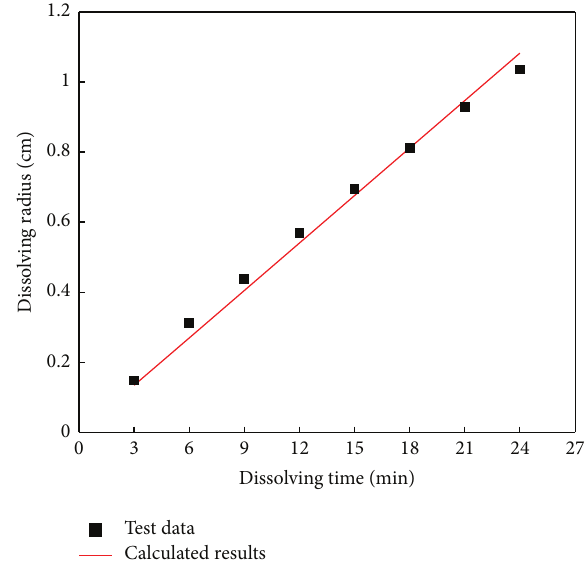
Figure10:Comparisonofthedissolvedradiusbetweentestdataand calculated results under 40 L/h.